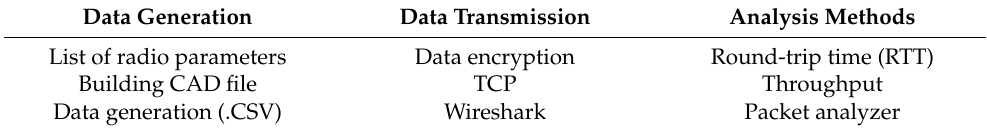
Table 1. The portions in the practice of the 5G digital twin.